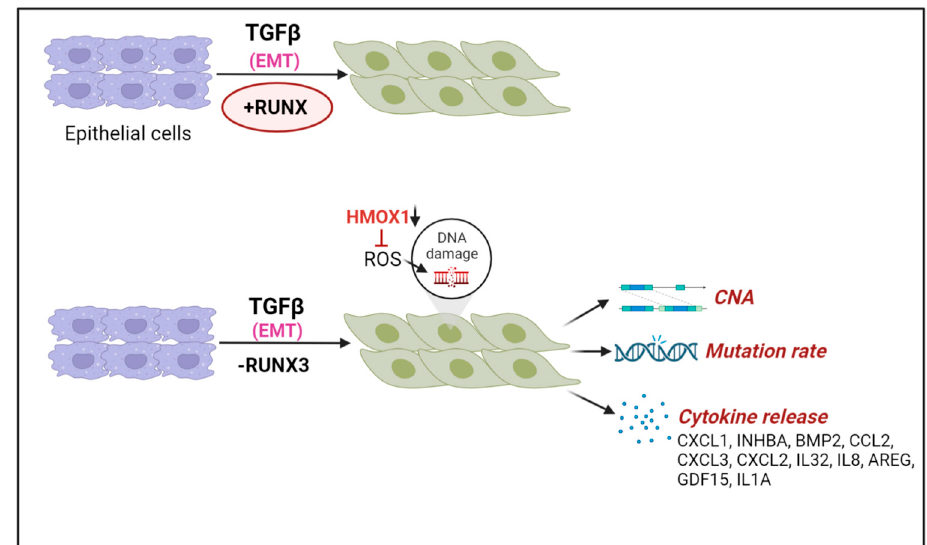
Figure 7. RUNX proteins guard genomic integrity after TGF β exposure. The loss of RUNX proteins triggers dramatic DNA damage cells in lung epithelial cells undergoing TGF β -dependent EMT. RUNX proteins reduce TGF β induced-oxidative stress by the transcriptional induction of the antioxidant HMOX1 . However, upon RUNX loss, TGF β induced much higher levels of oxidative damage, DSBs, and acquisition of the senescence-associated secretory phenotype (SASP), represented by CXCL1, INHBA, BMP2, CCL2, CXCL3, CXCL2, IL32, IL8, AREG, GDF15, and IL1A upregulation. Since inflammation can induce DNA damage, RUNX3 deficiency creates a self-re-enforcing feedback loop of inflammation and genomic instability.